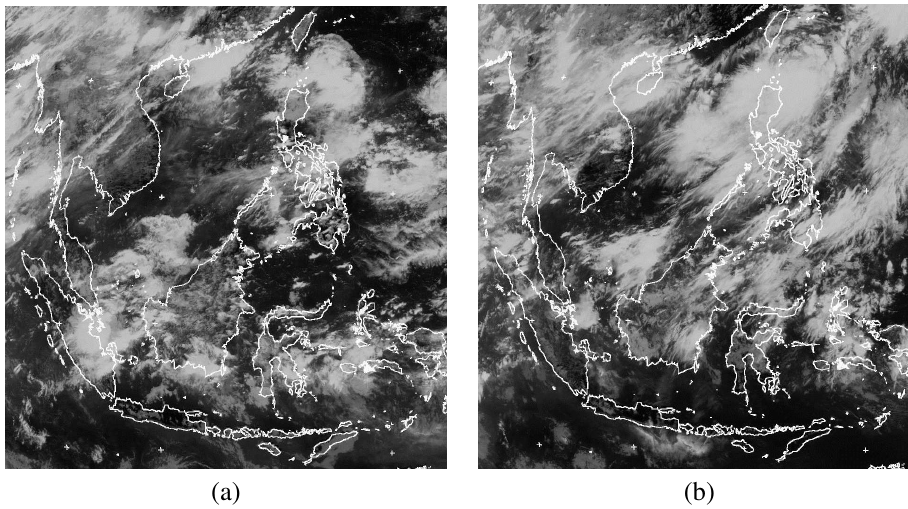
Fig. 4. Thermal infra-red images from the Multi-Functional Transport Satellite. Images are of (a) the 11 July 2008 and (b) 16 July 2008, both at 02:00p.m. LT. (a) shows little cloud cover upwind of Borneo to the south-east, with clouds forming over the island, particularly downwind of the Crocker Mountain range, suggesting the role of orographically induced convection. (b) shows the dominance of an MCS system to the north-east of Borneo, with little convective activity over the island. (a) is typical of conditions on the 13 and 14 July and (b) is typical of conditions on the 17 July.